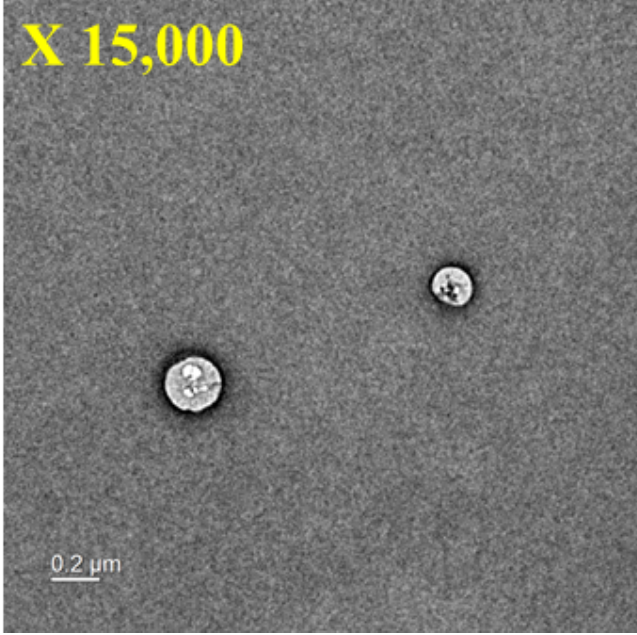
Figure 3. TEM images of NM-loaded micelle NPs.